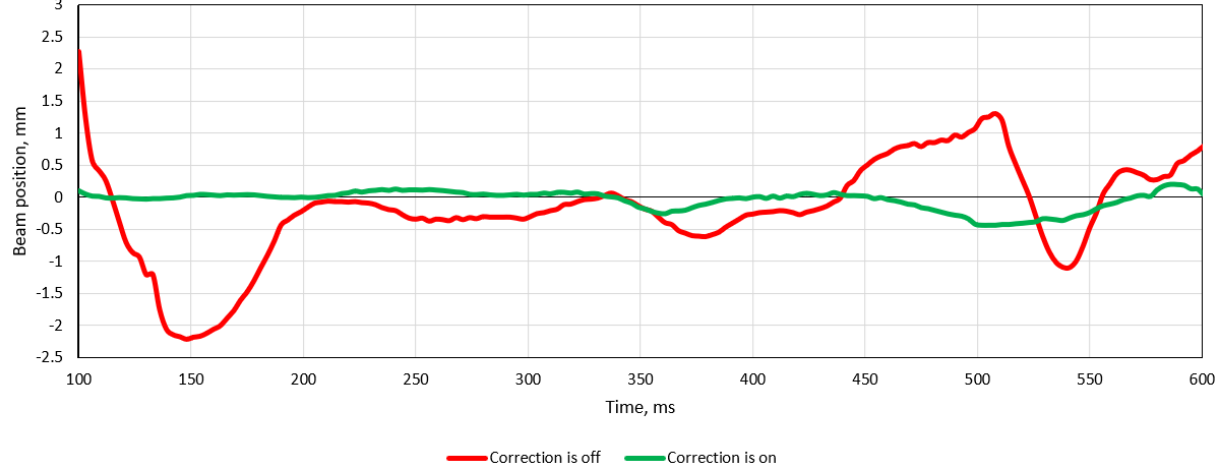
Figure 12. Fluctuations of the beam position on the 1st quadrant photodiode.